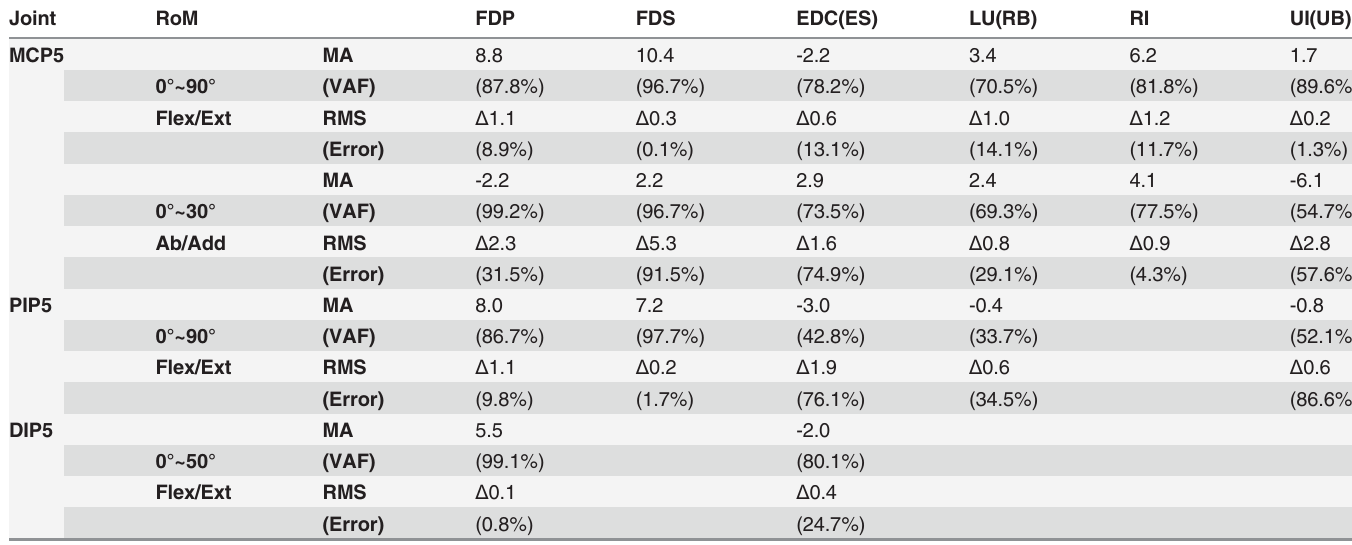
Table 6. Mean moment arms (MA) of the little finger.